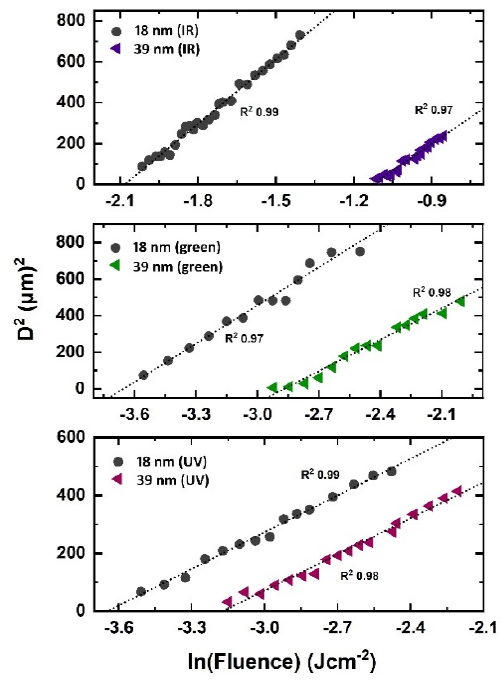
Figure 2. Plots between natural log of applied fluence and squared crater diameter for 18-nm and 39-nm Au films on quartz substrate for IR, green and UV laser wavelengths, respectively.